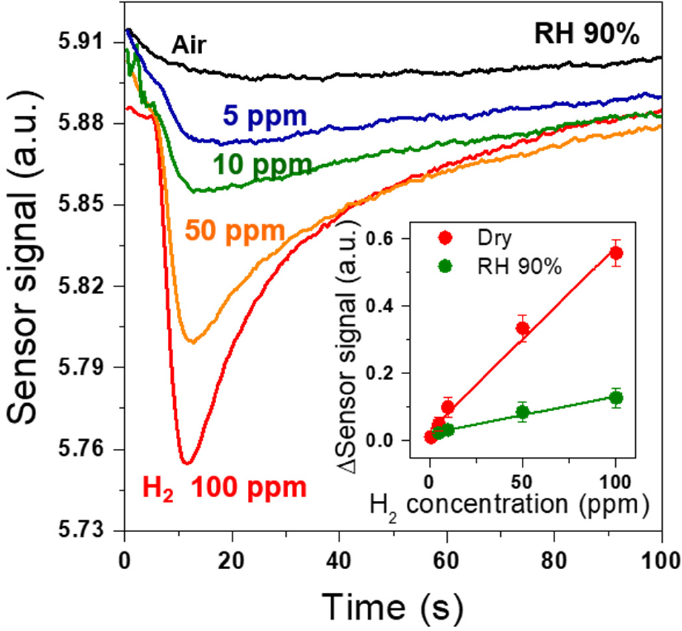
Figure 6. Sensor signals of Pd-coated SnO 2 NR arrays for various H 2 concentrations (5–100 ppm) at 90% RH and 152 °C; (inset) sensing response ( Δ Sensor signal) with increasing H 2 concentration in dry and 90% RH air.